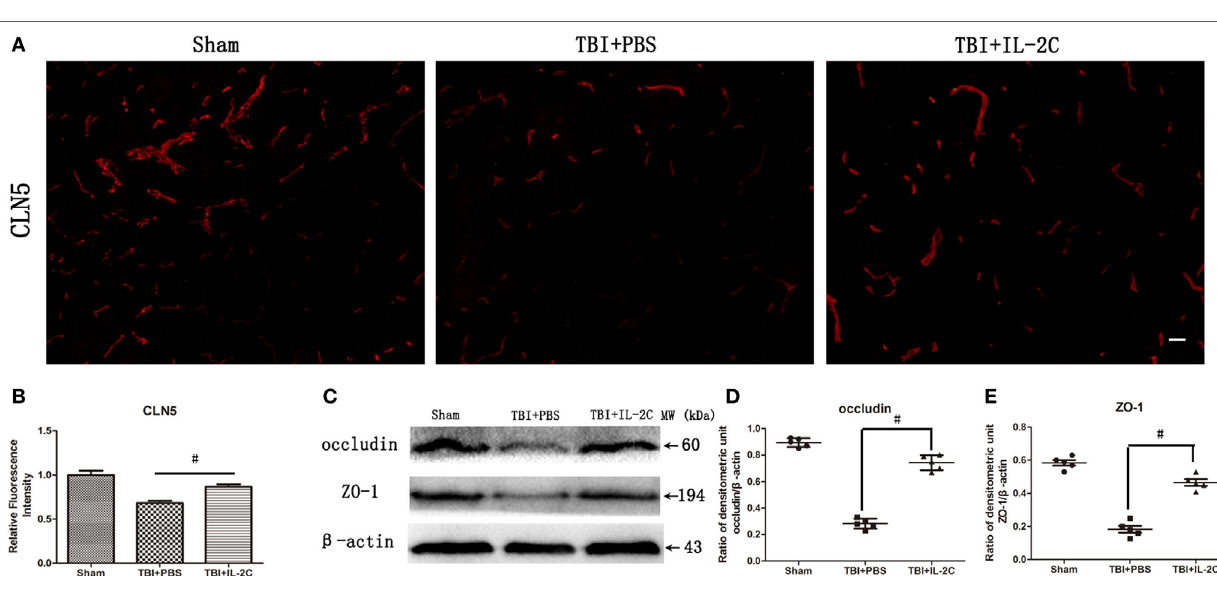
FigUre 8 | (a,B) Immunofluorescent staining and relative fluorescence intensity showed that treatment with IL-2C retained the continuity of the tight junction protein (TJ) CLN5. (c–e) IL-2C administration significantly increased the expression of TJs occludin and ZO-1 compared to the PBS treated group. Data are presented as the mean ± SD; * p < 0.05 and # p < 0.01 ( n = 5